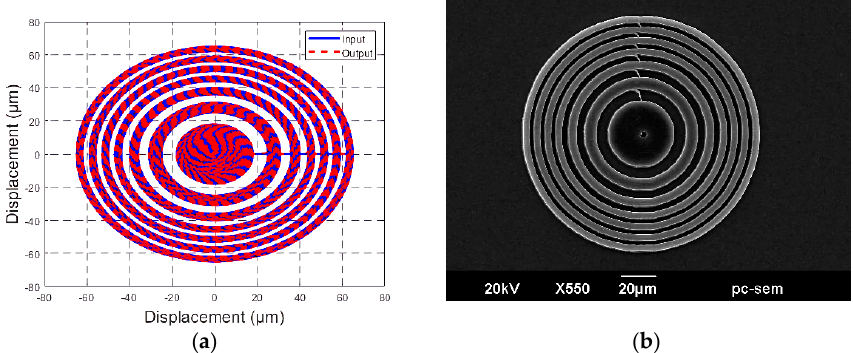
Figure 12. The design and fabrication of the FZP: ( a ) the lens design; ( b ) lens fabrication.